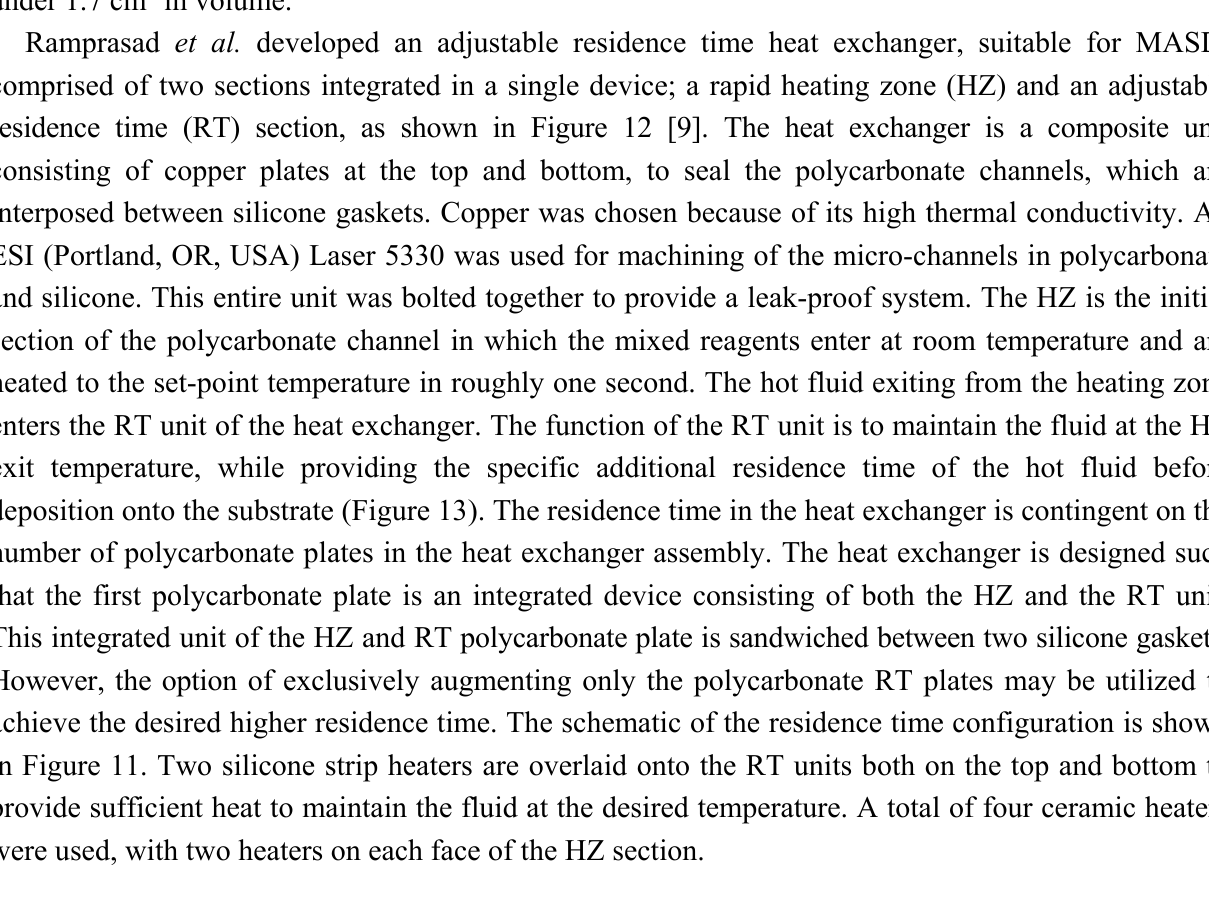
Figure 12. A schematic representation of residence time configurations available in the adjustable residence time heat exchanger ( a ) 1×; ( b ) 5×; ( c ) 10×. Reproduced from